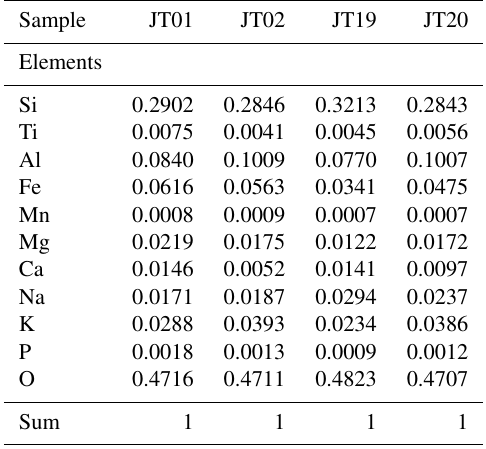
Table B2. Element weight percent data, transformed from oxide weight percent data with the use of Eq. (B5). All data have addi- tionally been scaled to satisfy the unit sum